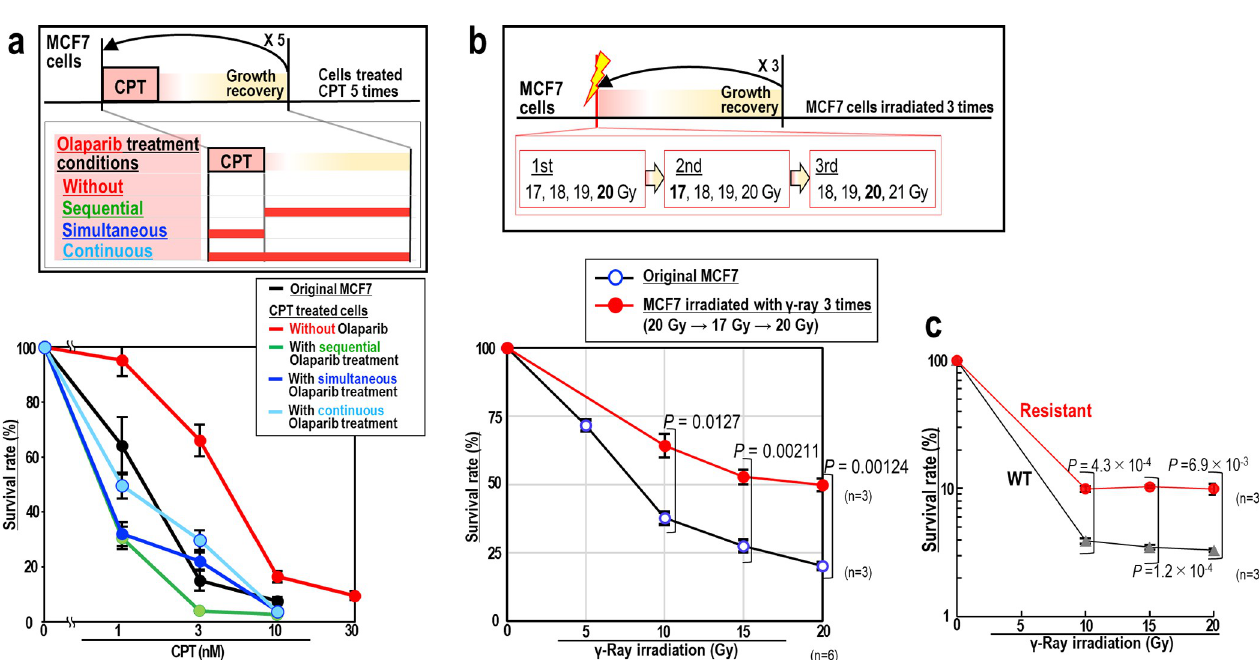
Fig 4. Radio- and CPT-resistance is suppressed by Olaparib. ( a ) MCF7 cells were treated with CPT, as shown in the upper panel, to induce resistance. Untreated and treated cells were subsequently treated with increasing concentrations of CPT, and their survival was assessed (n = 3 independent experiments). Graphs show mean survival rates ± s.d. from three independent experiments. ( b , c ) MCF7 cells were treated with γ -ray irradiation, as shown in the upper panel, to induce resistance (n = 3 independent experiments). Untreated and treated cells were subsequently irradiated by γ -ray, and their survival was assessed by cell counting ( b ) or MTS assay ( c ). Graphs show mean survival rates ± s.d. from three independent experiments. Two-tailed Welch’s t-test was used for statistical analysis.